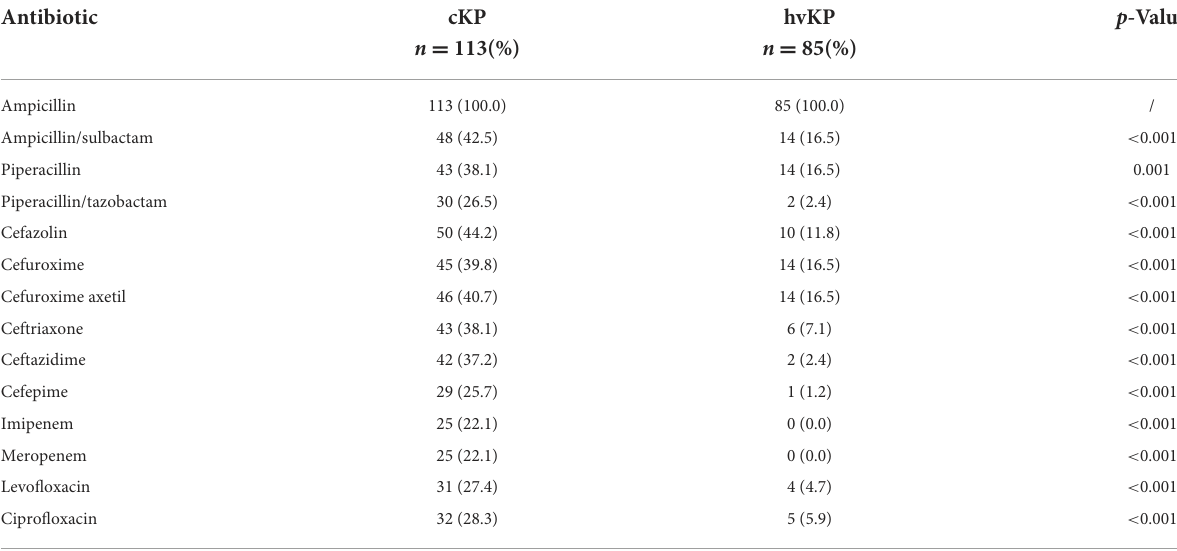
TABLE 1 The antibiotics resistance of KP isolated from inpatients. Antibiotic